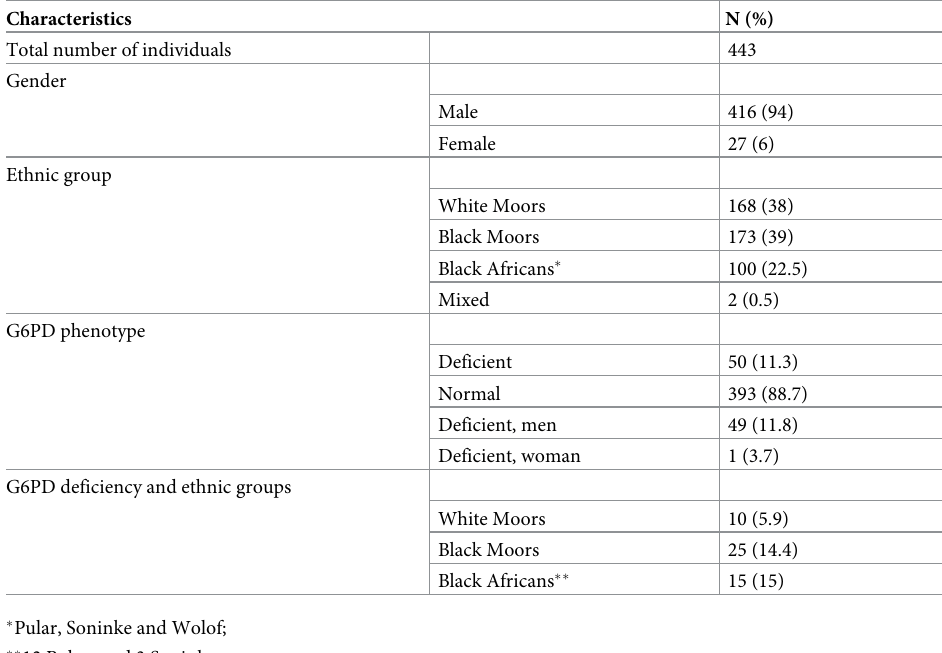
Table 1. Demographic characteristics and G6PD-deficient phenotypes using Carestart rapid diagnostic test in healthy blood donors in Nouakchott, Mauritania.